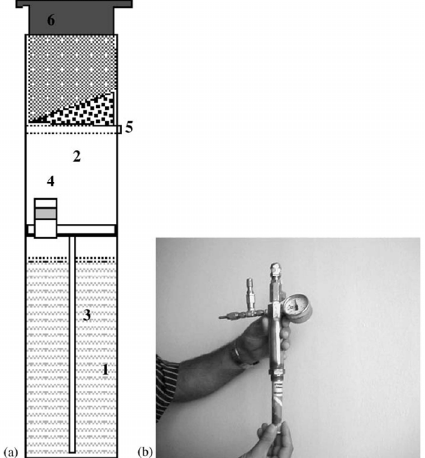
Figure 7. ( a ) A schematic of the hydrogen producing device: 1, HCl chamber; 2, reaction chamber; 3, connection channel; 4, pressure regulation valve; 5, diaphragm; 6, activation button; and ( b ) insertion of the device in the reaction chamber. Reprinted with permission from reference [105]. Copyright 2006 Elsevier.